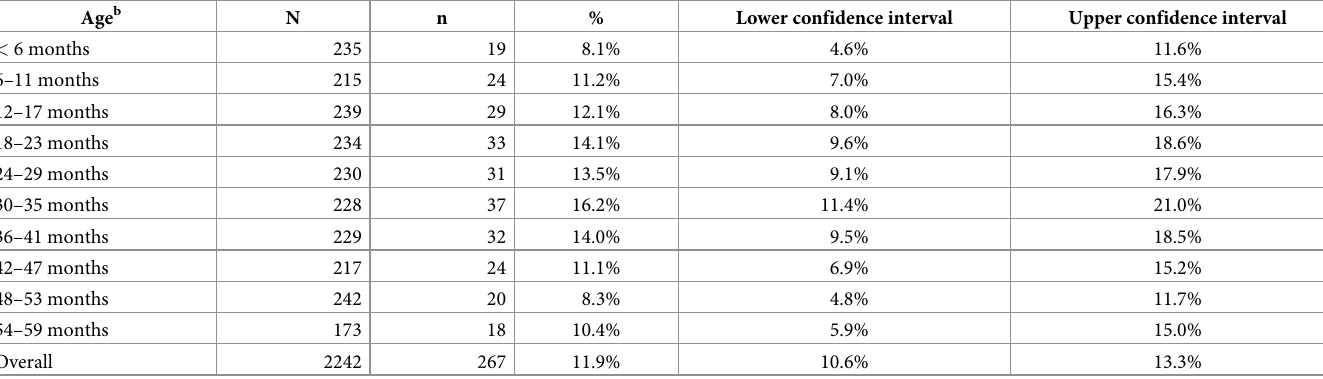
Table 2. 12-month prevalence of atopic dermatitis according to the International Study of Asthma and Allergies in Childhood (ISAAC) questionnaire a .